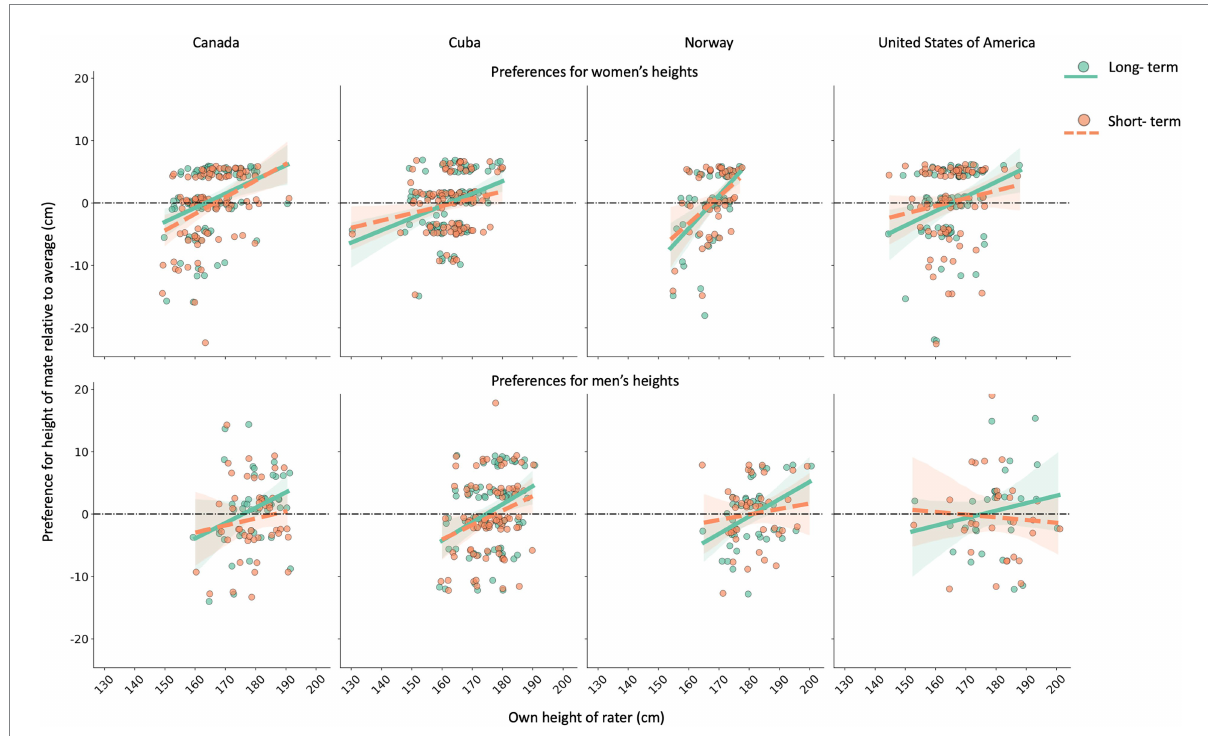
FIGURE 2 Assortative preferences for the heights of potential female mates (top row) and male mates (bottom row) in all four countries. The heights of raters positively predict how much taller-than-average or shorter-than-average they prefer their mates to be, with similar effects observed across countries. Men’s preferences for women’s heights are relatively stronger for a long-term (solid lines and green coloration) than short-term (dashed lines and orange coloration) relationship context. 95% confidence intervals are represented by shaded regions surrounding each regression